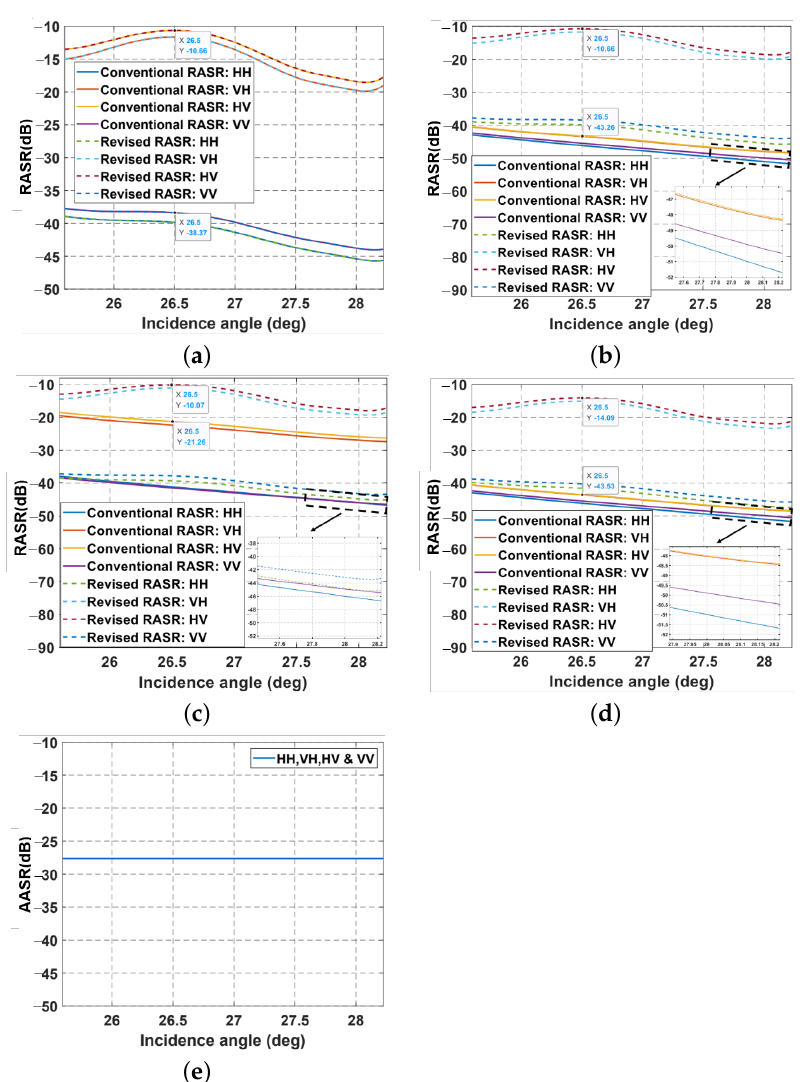
Figure 8. RASRs and AASRs for the LT-1 system operating in the conventional quad-pol. ( a ) RASRs without waveform diversity. ( b ) RASRs with up-down chirp waveforms. ( c ) RASRs with OFDM chirp waveforms. ( d ) RASRs with quasi-orthogonal NLFM waveforms. ( e )